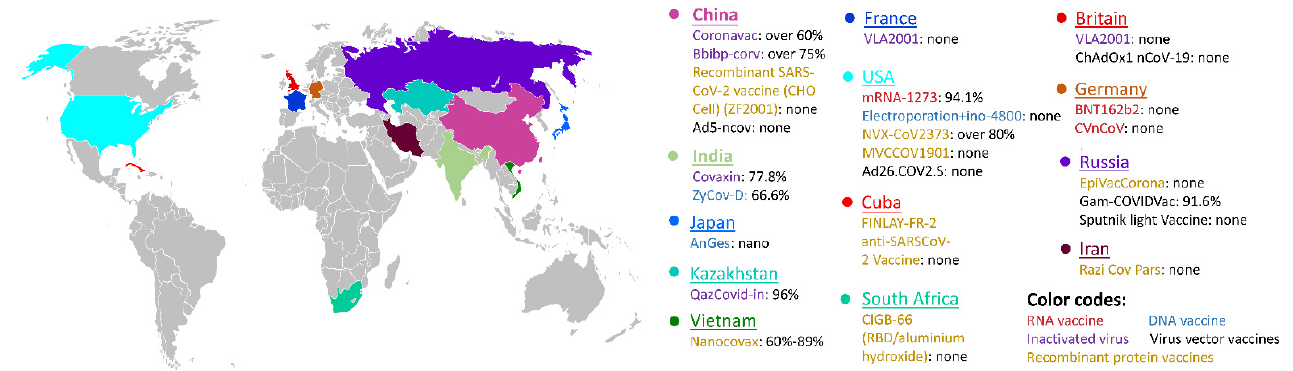
Figure 11. Global COVID-19 vaccines map. The use and development of COVID-19 vaccines is sum- marized in different continents.